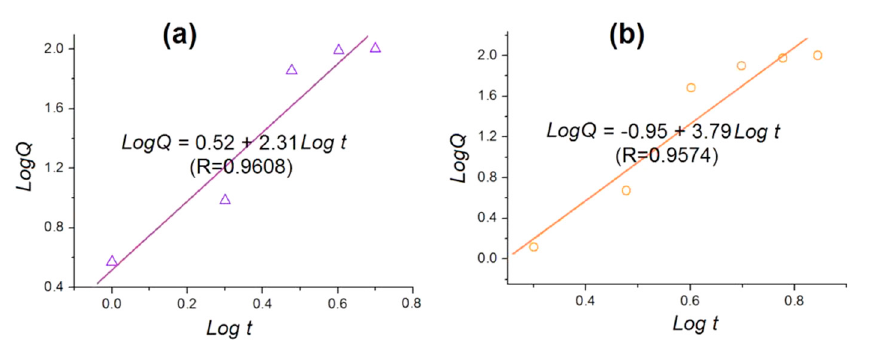
Figure 9. The regressed equations of aspirin release data of nanofibers from different electrospinning processes according to the Peppas equation: ( a ) MCFs; ( b ) CSFs.